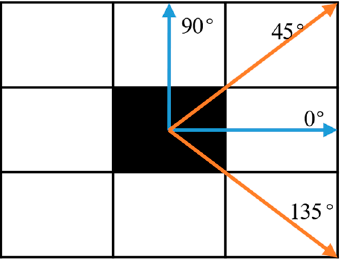
Figure 4. Illustration of edge directions in a digital image. The orange arrows represent the 45° and